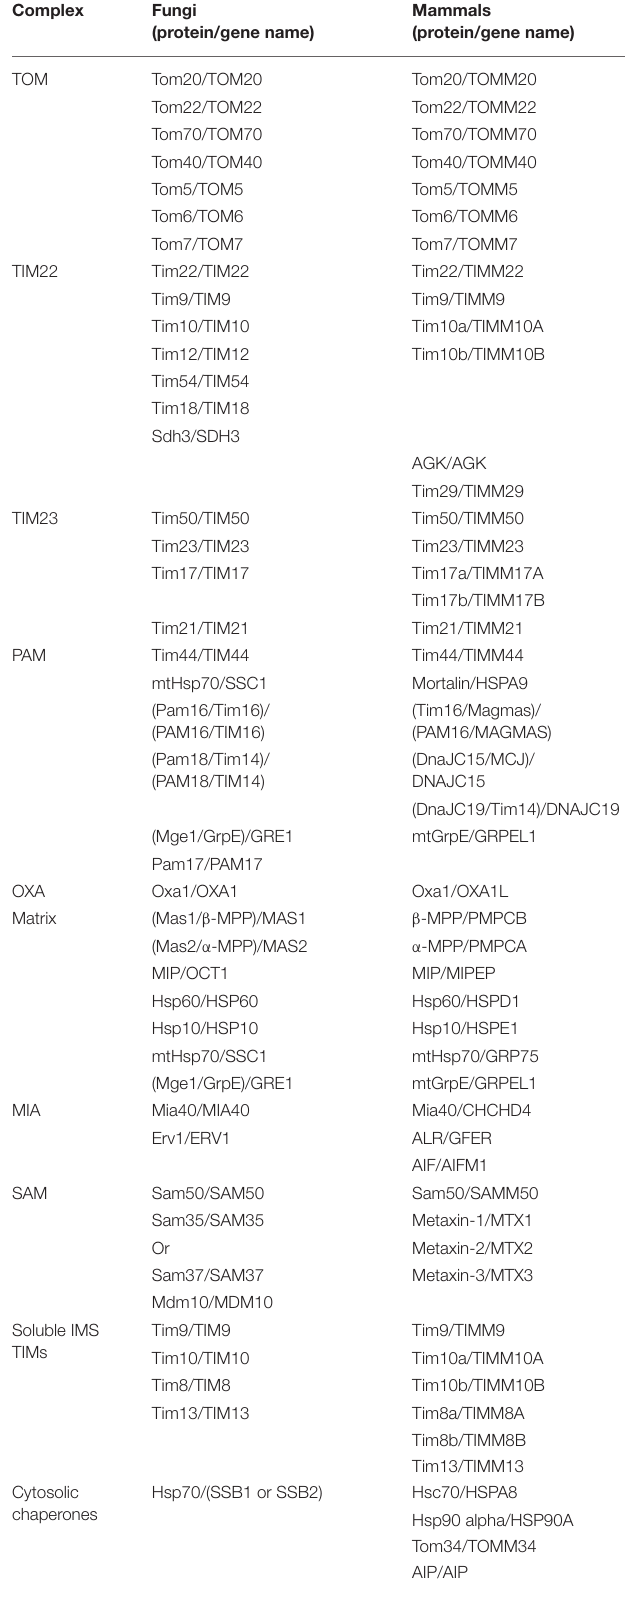
Mammals (protein/gene